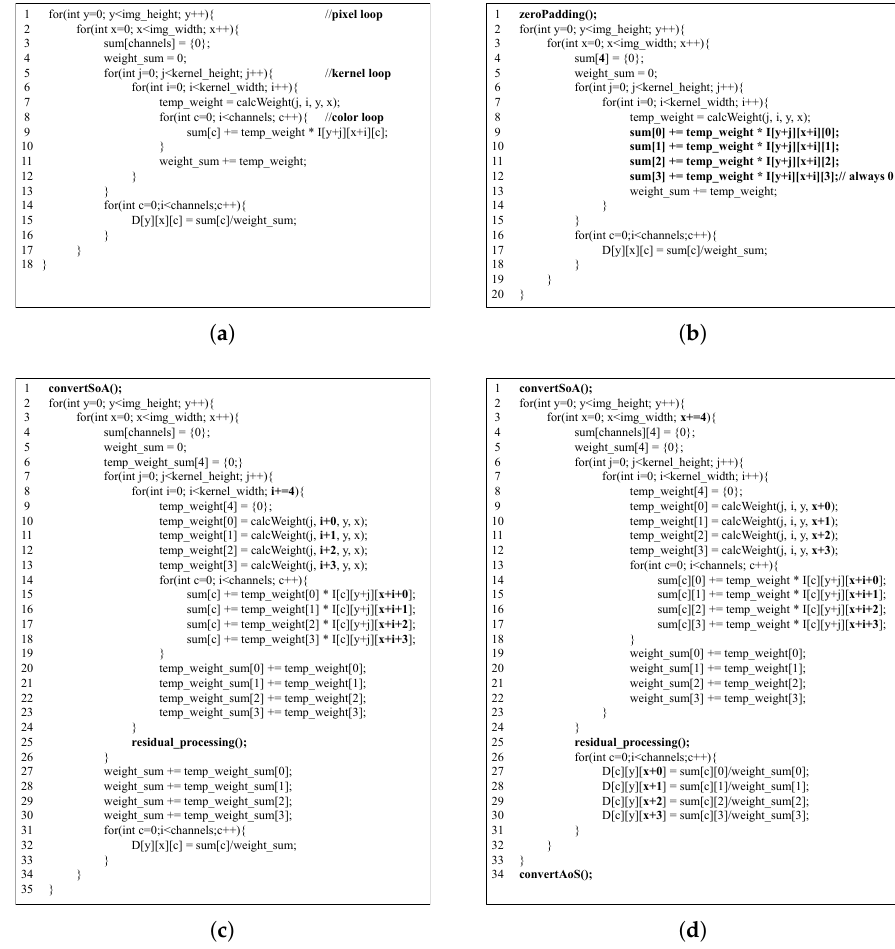
Figure 4. Code of vectorization patterns. ( a ) Brute-force implementation; ( b ) Color loop unrolling; ( c ) Kernel loop unrolling; ( d ) Pixel loop unrolling. The size of the SIMD register is 4. Usually, the data structure I [ y ][ x ][ c ] represents RGB interleaving, where x and y are the horizontal and vertical positions, respectively, and c is the color channel. Splitting and merging the data by each channel are defined as follows: I [ y ][ x ][ c ] ⇔ I [ c ][ y ][ x ] . For these data structures, the data in the final operator [ · ] can